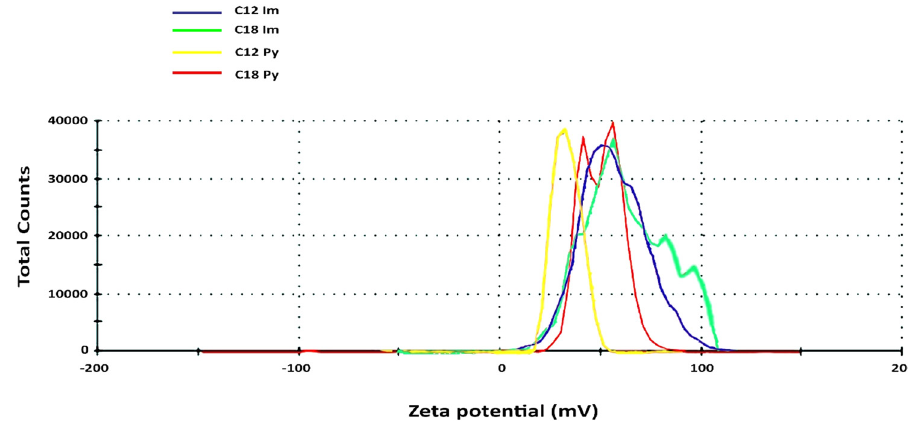
Figure 2: Zeta potential distribution of di ff erent ionic liquid - coated Ag